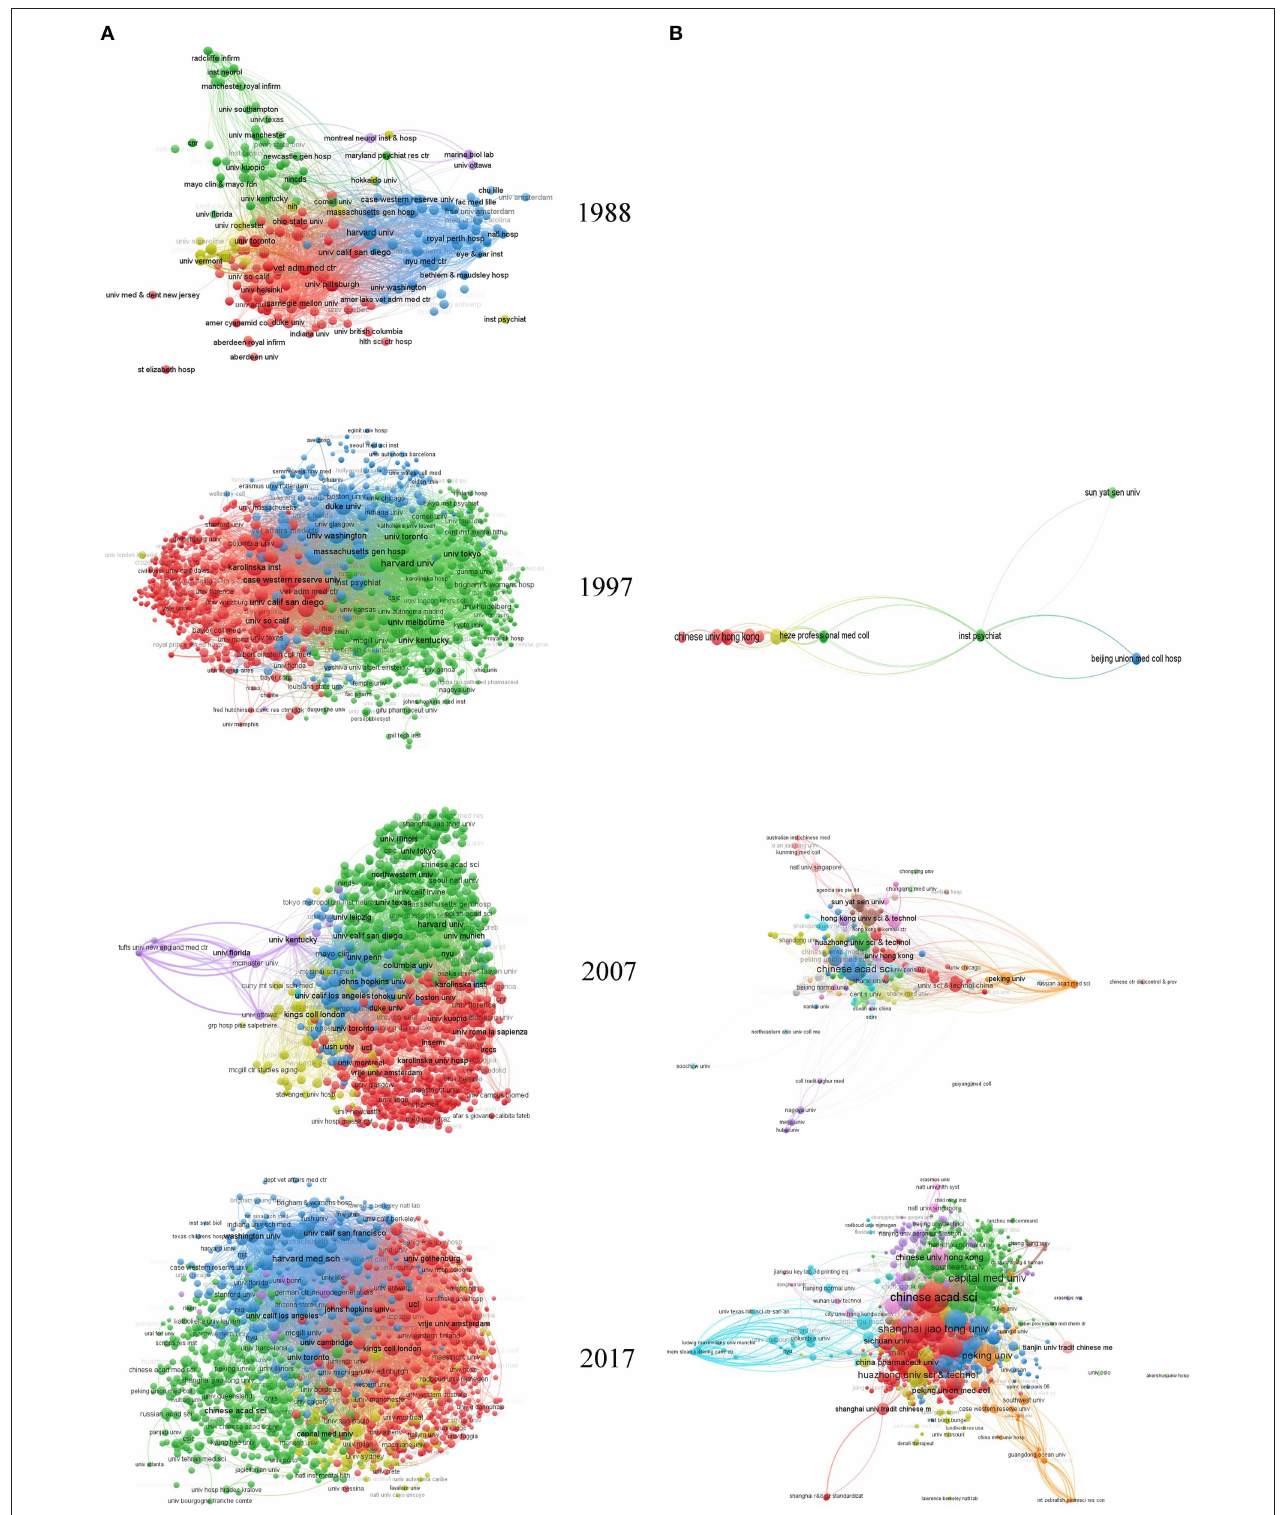
FIGURE 6 | Institution maps globally and in China. In this visualized network, each institution is represented by a node. Node size reflects the number of publications in the node, and two nodes are connected by a curved line if either of them cites the other. Curved lines between nodes reflect the connectivity of nodes, with line thickness representing the number of citations between two nodes. VOSviewer has its own clustering technique based on citation relations between clusters. Colors represent groups of nodes that are relatively strongly related to each other. (A) Global institution maps. (B) Institution maps in China.